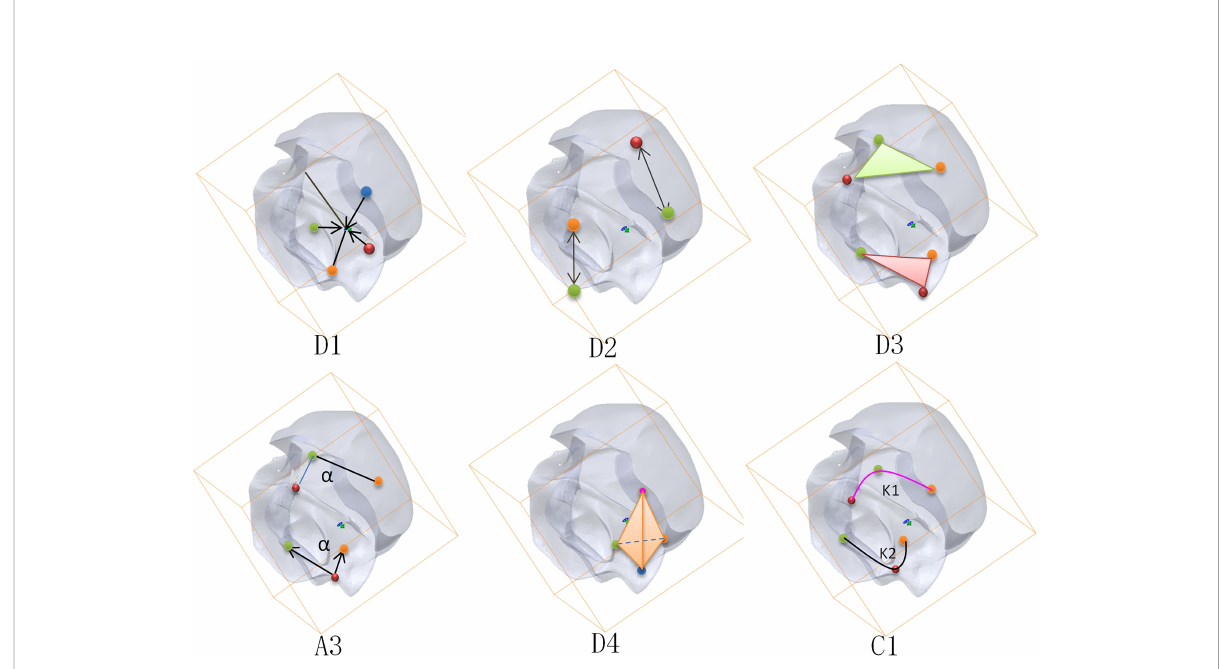
FIGURE 1 Characteristic diagram of common shape-distribution